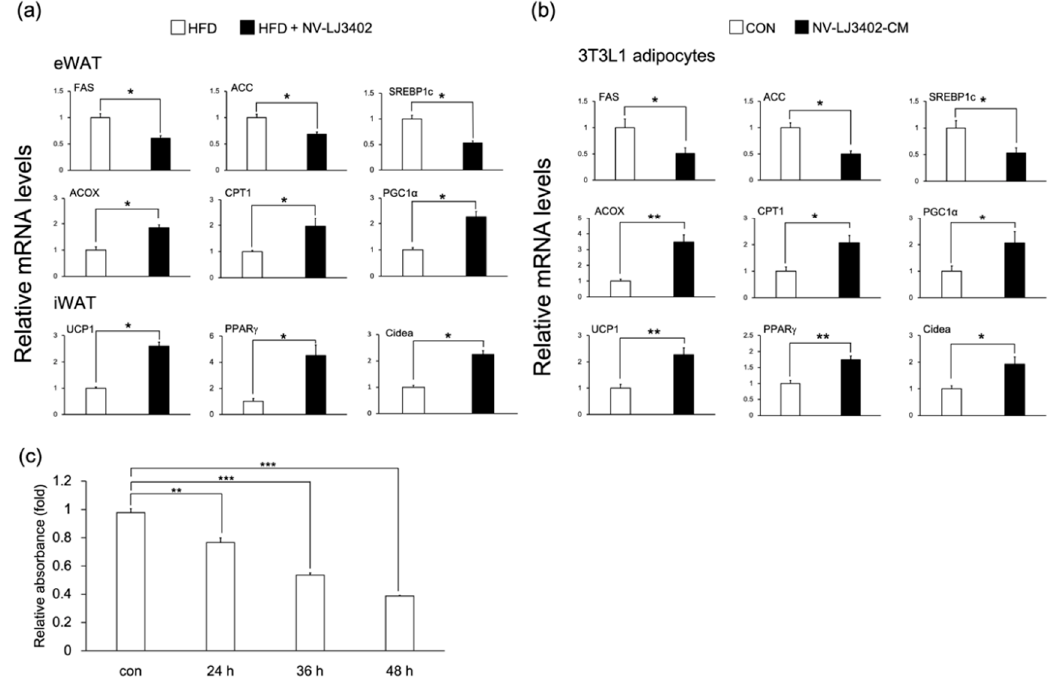
Figure 2. The e ff ect of NV-LJ3402 on metabolic gene expression in the WATs of HFD-fed mice and 3T3-L1 adipocytes. After 14 weeks of NV-LJ3402 administration to HFD mice or 48-h treatment of day 6 3T3-L1 adipocytes with NV-LJ3402-CM or control bacterial culture medium (con), the expression of genes coding for proteins involved in lipogenesis and energy dissipation in WATs ( a ) and 3T3-L1 adipocytes ( b ) were determined by Real time-quantitative PCR (RT-qPCR), as indicated. ( c ) 3T3-L1 adipocytes were treated with NV-LJ3402-CM for di ff erent time periods, as indicated. Lipid accumulation in 3T3-L1 adipocytes was analyzed on day 8 by Oil Red O staining. All data are expressed as the mean ± S.E.M. The experiments using WATs were performed with n = 6–7 per group, and the results using 3T3-L1 adipocytes are from three independent experiments. HFD vs. HFD + NV-LJ3402, con vs. NV-LJ3402-CM, * p < 0.05, ** p < 0.01, *** p < 0.001.